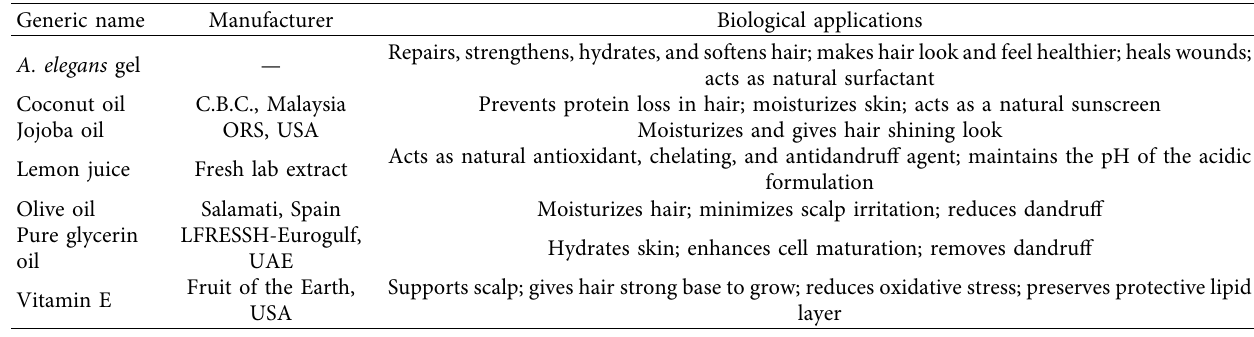
Table 1: Ingredients used in preparing lab-made hair washing formulations from A. elegans gel. Generic name